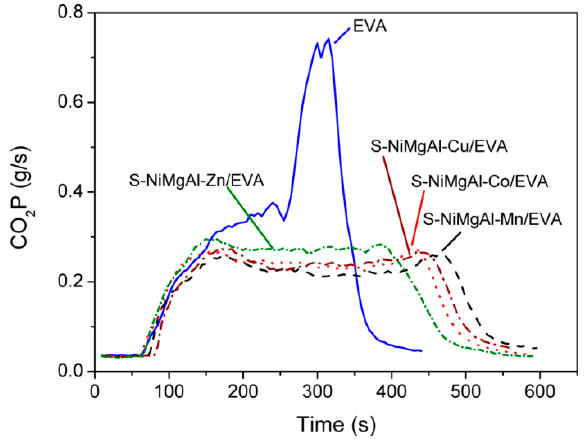
Figure 10. CO 2 P curves of EVA and its composites with 20 wt. % LDHs.